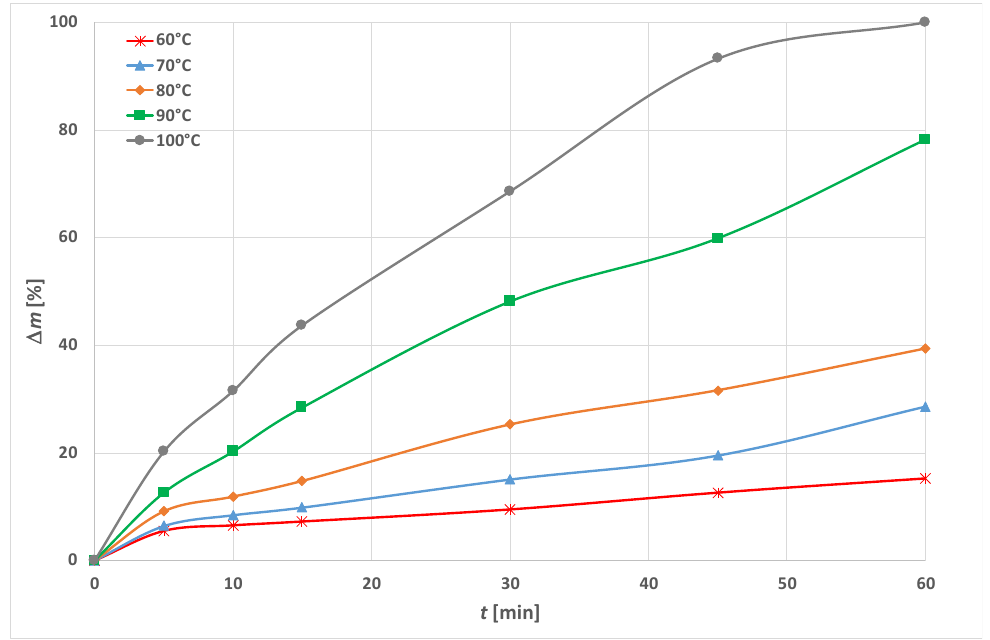
Figure 4. Dissolution of PET fibers in 1.5 mol cm − 3 NaOH with addition of 1 gcm − 3 HDTMAC at temperature range 60 to 100 °C expressed as weight loss ( Δ m ). Table 1. Breaking force ( F ) of PET fabrics before and after hydrolysis at 60 to 100 °C.